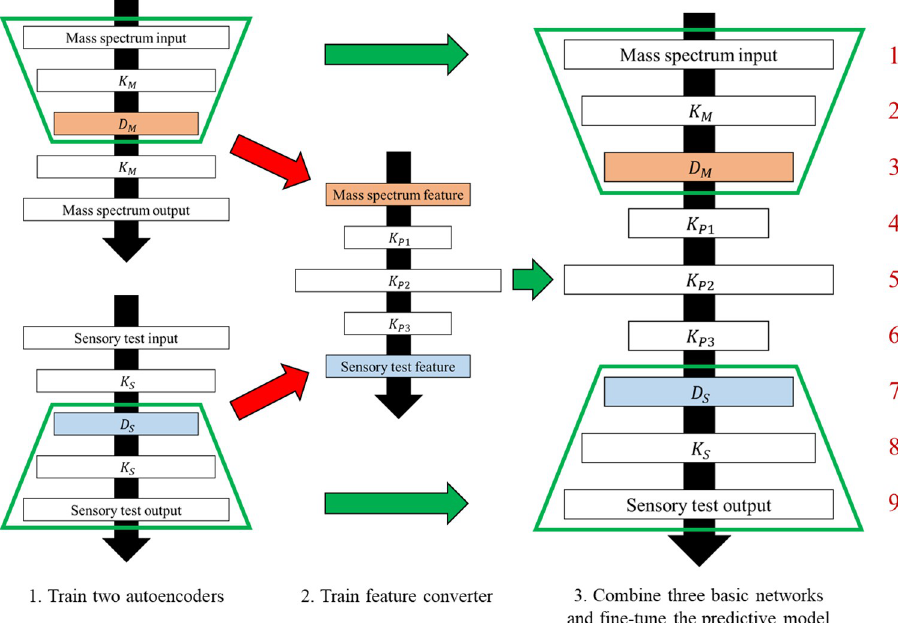
Fig 2. Schematic diagram of the odor impression predictive